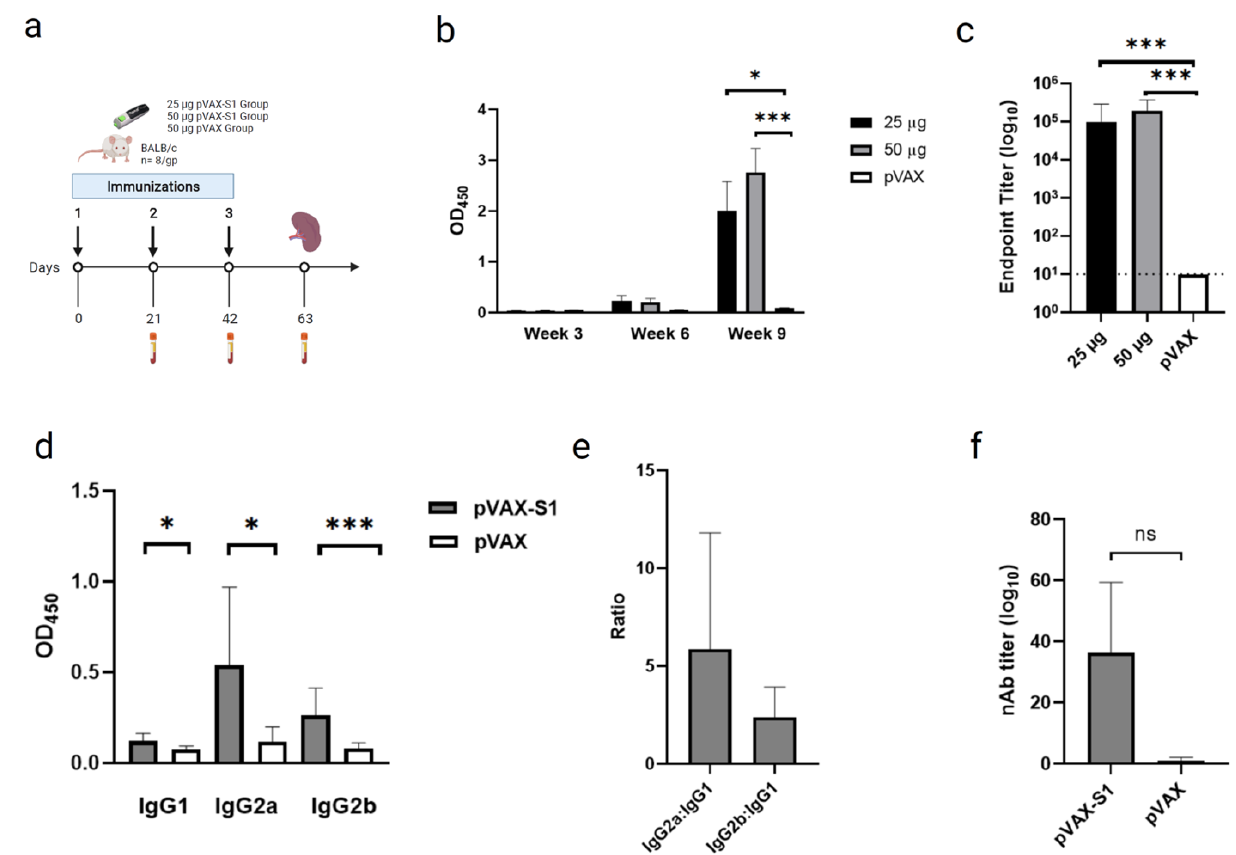
Figure 2. Humoral immunity in pVAX-S1 immunized mice. ( a ) Animal experimental plan. Mice were divided into three experimental groups ( n = 8) and immunized intramuscularly with three doses on days 0, 21 and 42 using 25 µg or 50 µg of pVAX-S1, or 50 µg of pVAX1 using a customized needle-free Tropis system (PharmaJet, Golden, CO, USA). ( b ) Mean optical density (OD) values of S1-specific binding total IgG at 1:100 dilution as determined by ELISA at 3, 6 and 9 weeks after immunizations. ( c ) Mean end-point titers of S1-specific total IgG as determined by ELISA in samples collected on week 9. ( d ) Mean OD values of S1-specific IgG1, IgG2a and IgG2b in pVAX-S1 (50 µg) and pVAX immunized animals as determined by ELISA on week 9. ( e ) IgG2a:IgG1 and IgG2b:IgG1 ratios calculated from samples collected on week 9 from immunized mice in the group that received the 50 µg dose of pVAX-S1. ( f ) The median inhibitory concentration (IC 50 ) of neutralizing antibodies (nAbs) was determined against rVSV- Δ G/SARS-2-S*-luciferase pseudovirus as described in the materials and methods. Data are depicted as mean ± SD. Statistical significance is reported as *, p ≤ 0.05, ***, p ≤ 0.001, and ns, not significant.